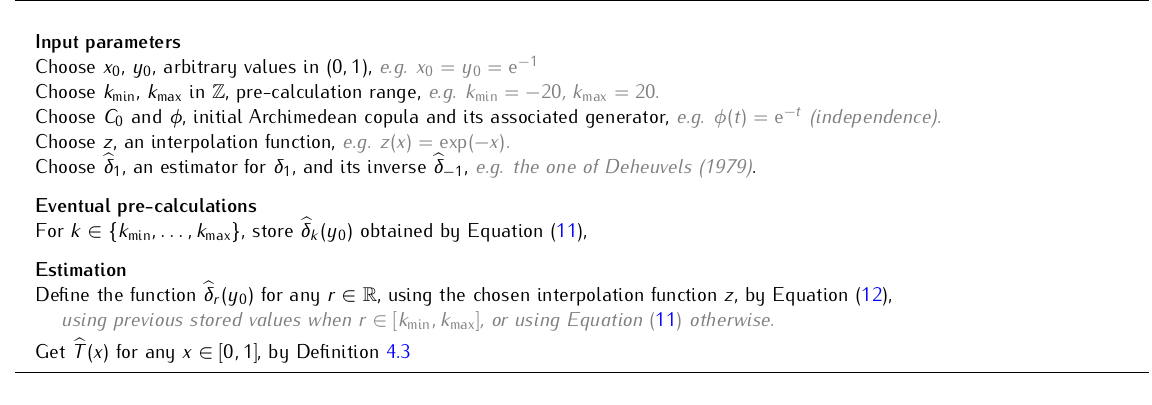
Algorithm 1 Detailed procedure for non-parametric estimation of a transformation T